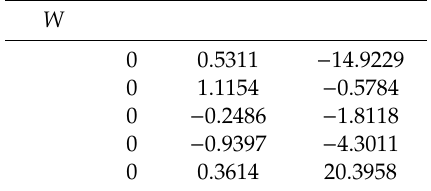
Table 5. Well-trained FCM clustering / piloting RBF-ANN model embedded / deployed on-site on the Arduino MEGA 2560 MCU as edge analytics for on-line load monitoring in DSM in this